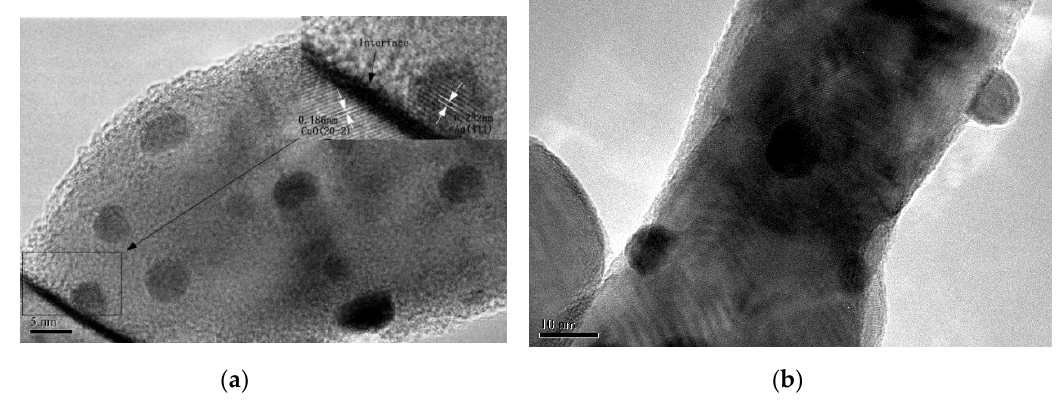
Figure 5. HR-TEM images of Au 1.0 /CuO-300 ( a ) and Au 1.0 /CuO-500 ( b ).